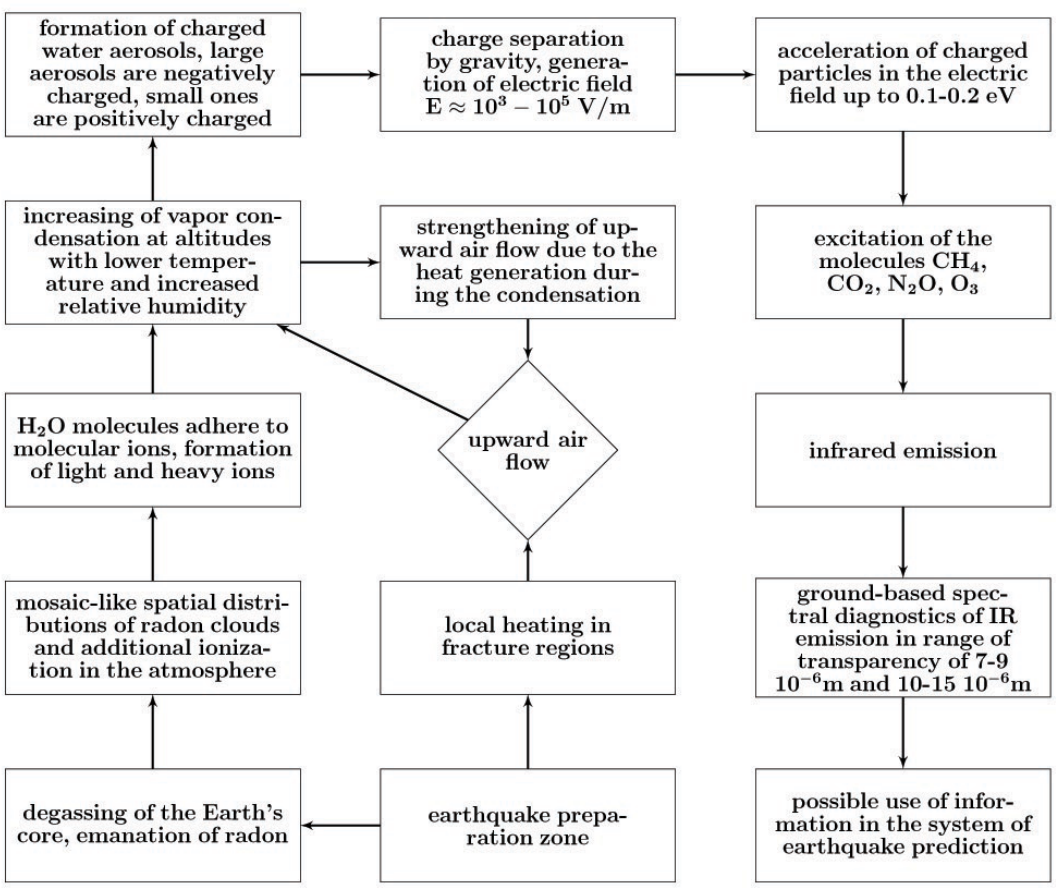
Fig. 1. Sequence of processes resulting in the generation of infrared emissions in the atmosphere before